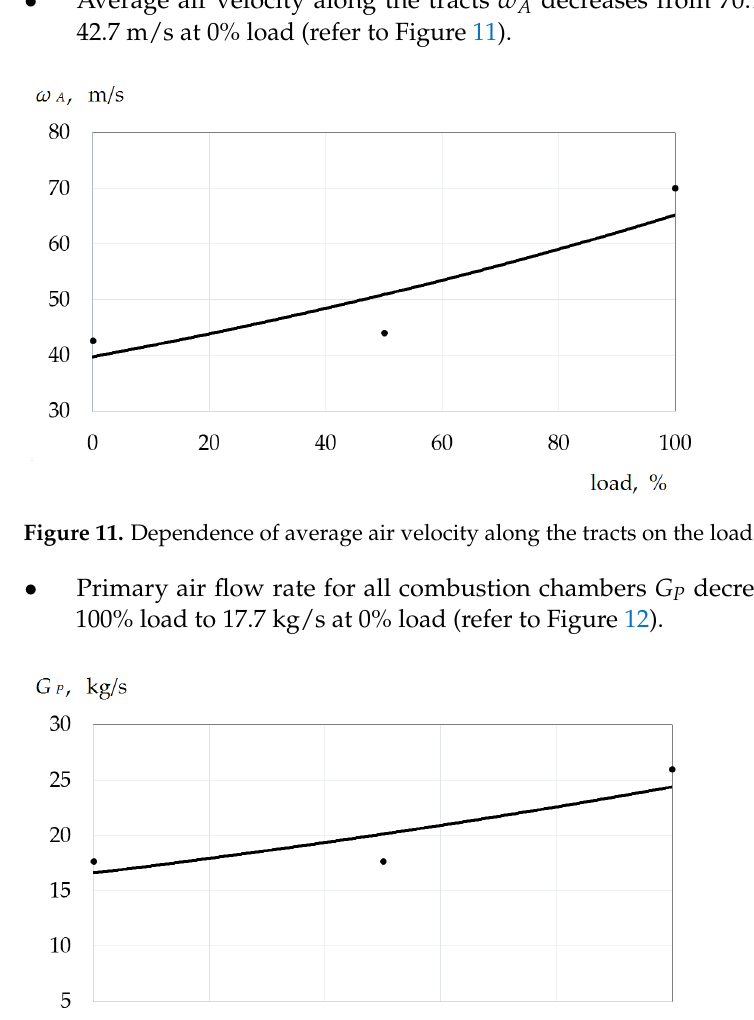
Figure 13. Dependence of air flow rate to registers for all combustion chambers on the load value.